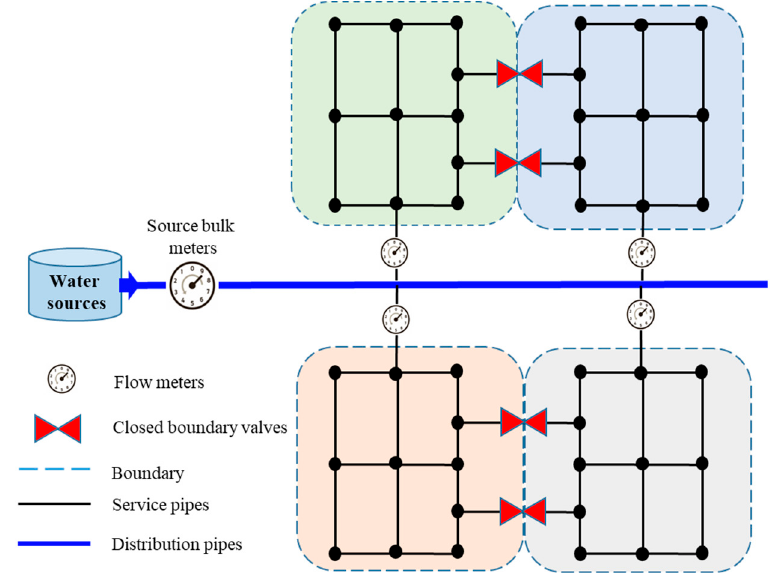
Figure 1. A schematic diagram of district metered areas.